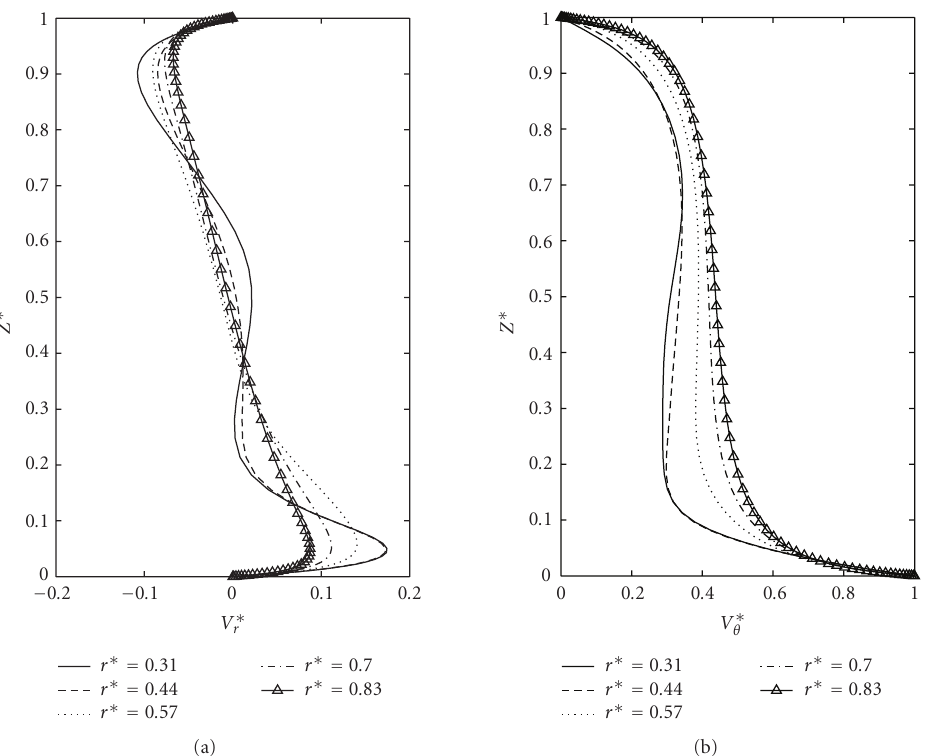
Figure 6: Axial profiles of the mean radial and tangential velocity components for Re = 10 6 and G = 0 . 02 at di ff erent radial locations r ∗ .